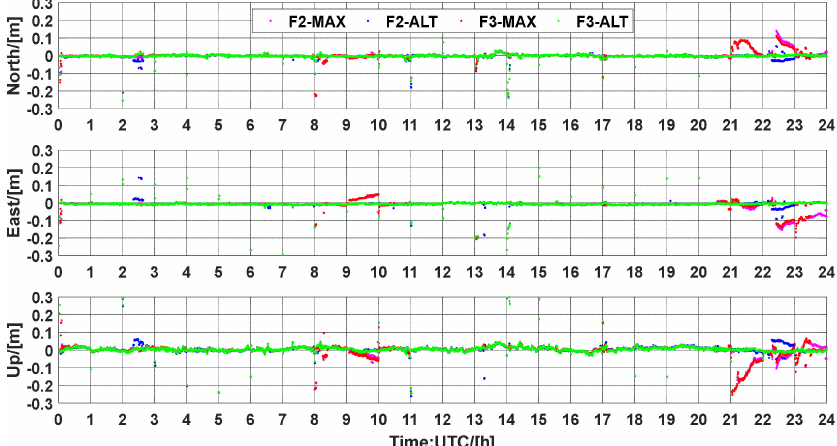
Figure 17. Position errors for UCPPP PAR using the atmospheric corrections from WARE station on DOY 083, 2021.